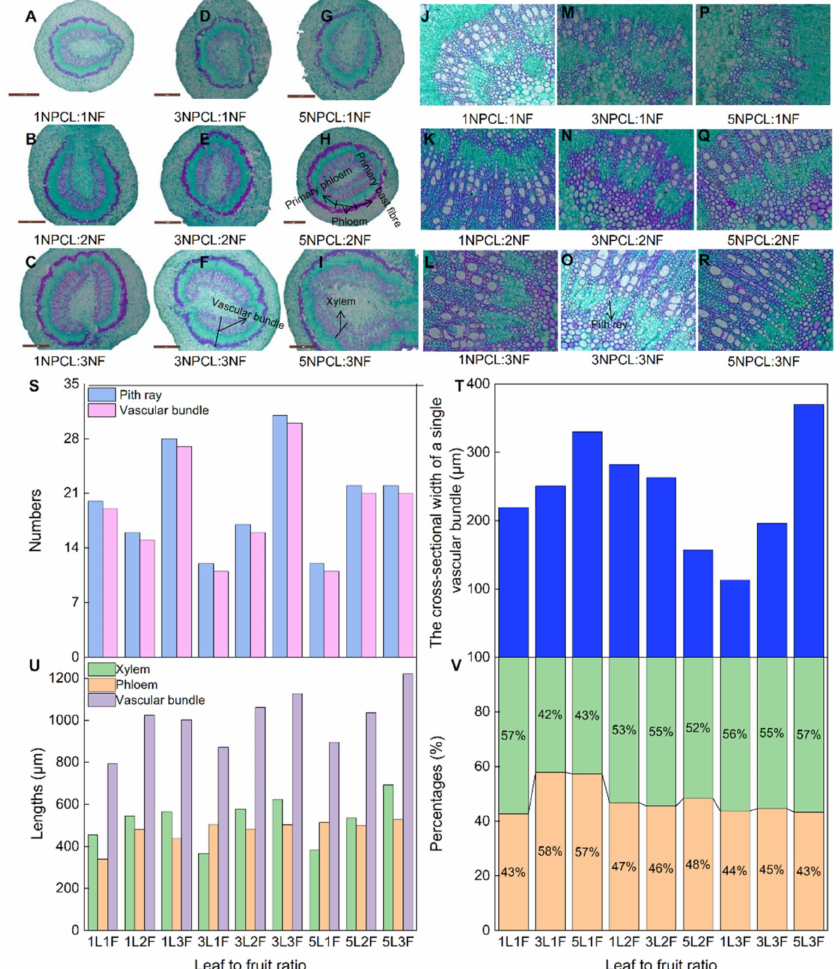
Figure 7. Effects of the source–sink relationship on fruit stalk anatomical structure. Shown ( A – I ) are the development diagrams under the 2.5 × objective lens field of view. Shown ( J – R ) are the develop- ment diagrams under the 20 × objective